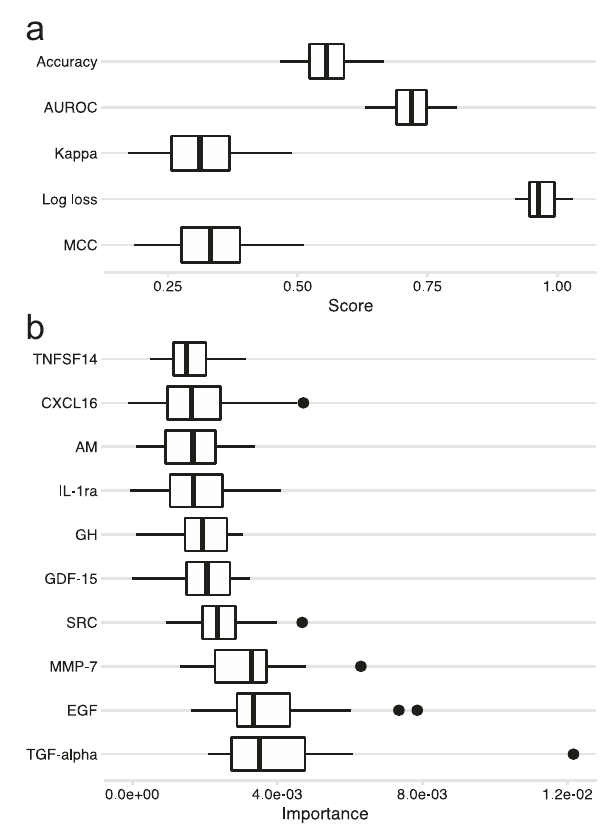
Fig. 2 Overview of classi fi er performance. Boxplots showing ( a ) classi fi cation metrics (accuracy, area under receiver operating curve (AUROC), Cohen ’ s kappa, Matthew ’ s correlation coef fi cient (MCC), log loss), and ( b ) importance score for the ten most in fl uential proteins across the 25 outer loops (5 folds × 5 repeats). CXCL16 C-X- C motif chemokine 16, IL-1ra Interleukin 1 receptor alpha, AM Pro- adrenomedullin, GH Somatotropin, SRC proto-oncogene tyrosine- protein kinase Src, GDF-15 growth/differentiation factor 15, MMP-7 matrilysin, EGF pro-epidermal growth factor, TGF-alpha protrans- forming growth factor alpha, TNFSF14 tumor necrosis factor ligand superfamily member